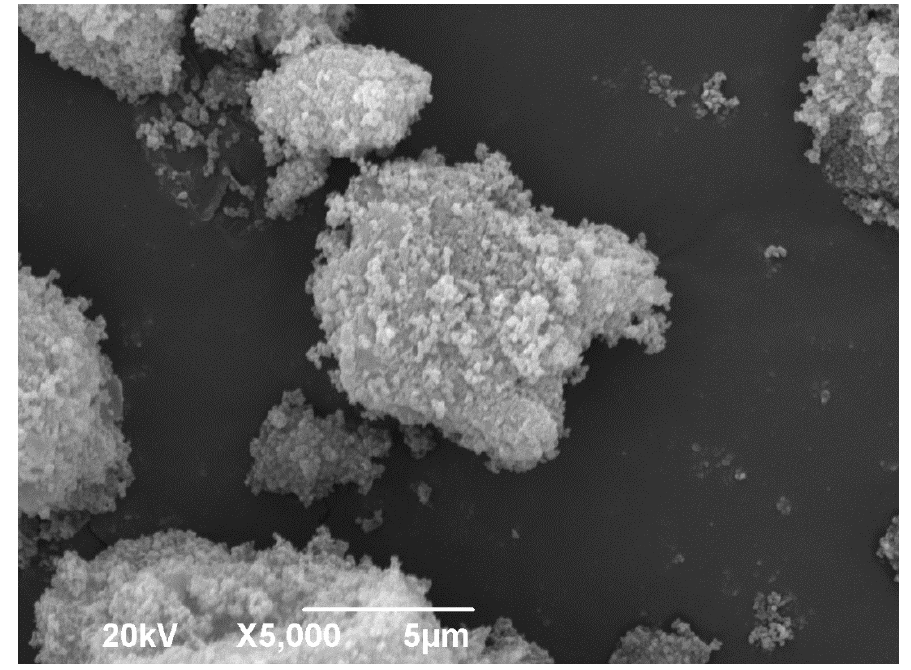
Figure 6. SEM micrograph of the TiO 2 -GO.